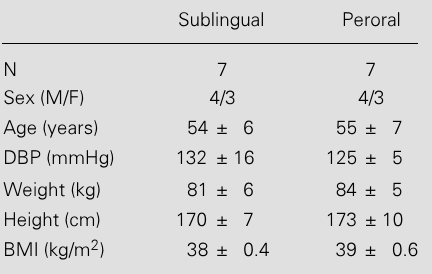
Table 1 - Clinical characteristics of the